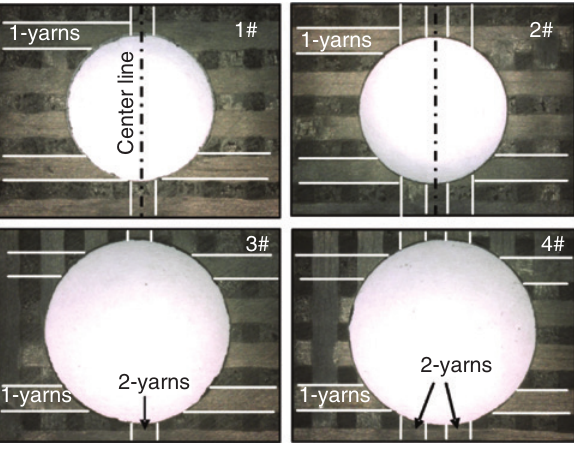
Figure 3: The local meso-structure around the drilling